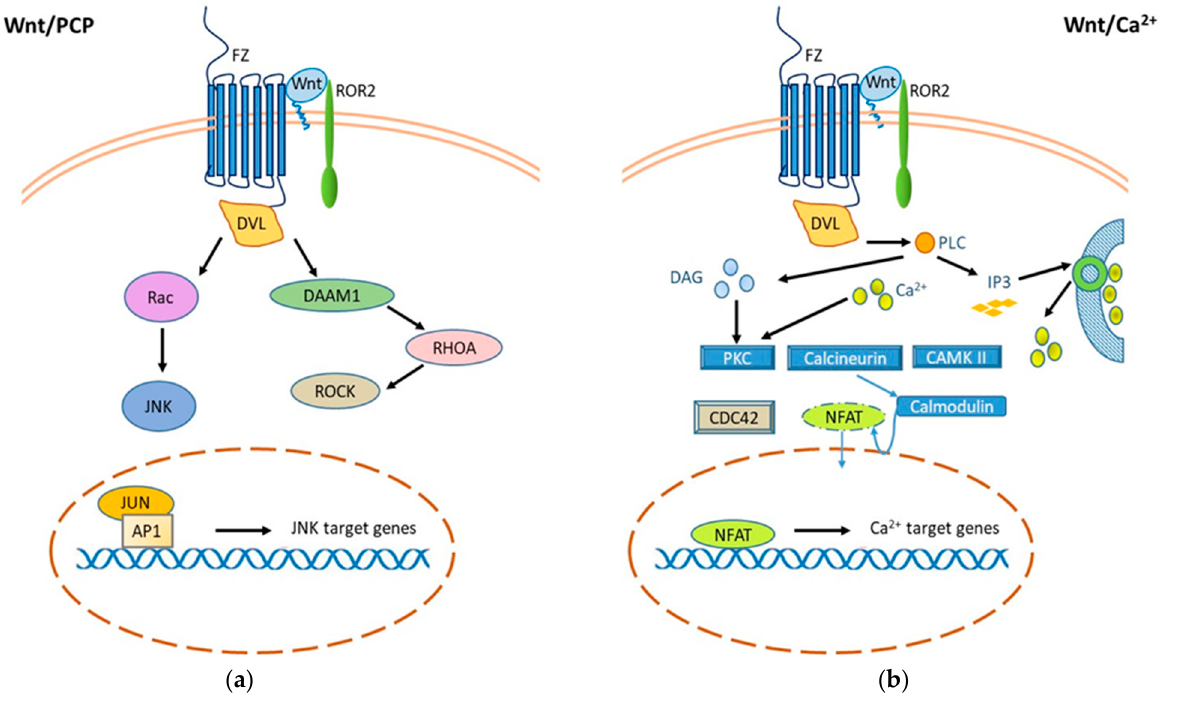
Figure 2. Wnt/ β -Catenin-independent signaling. Two non-canonical β -catenin-independent Wnt signaling pathways have been reported, both of which are activated by binding of a Wnt ligand to Fz proteins and their co-receptor tyrosine kinase-like orphan receptor 2 (ROR2) to activate Dishevelled (Dvl). ( a ) The planar cell polarity (PCP) pathway mediates cell adhesion, migration, and cytoskeleton organization. Activation of a trimeric G protein induces activation of Dvl and DAAM, which downstream activate the small GTPases RHOA and RAC-1 and the kinases JUN (JNK) and ROCK. The signal is amplified by the activation of JNK, which phosphorylates the transcription factors AP-1 and JUN that translocate into the nucleus and regulate gene expression. ( b ) The Wnt/Ca 2+ signaling pathway is mediated by G proteins with activation of phospholipase C, leading to hydrolysis of PIP2 to DAG and IP3. IP3 induces the diffusion of Ca 2+ ions from within the compartments in which they are stored into the cytoplasm to activate calcineurin and CAMKII. Intracellular calcium and DAG activate protein kinase C (PKC) by increasing calcineurin activity, which causes translocation of the transcriptional factor NFAT into the nucleus and target genes